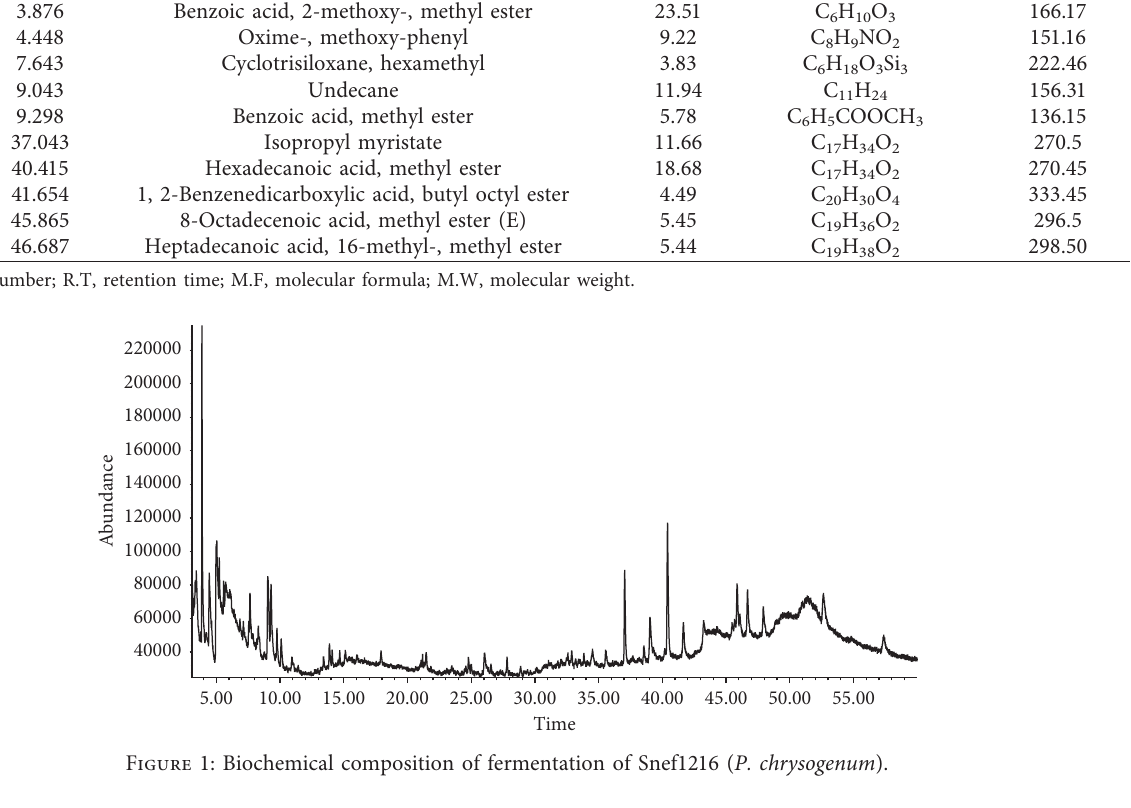
Table 3: Biochemical composition of fermentation of Snef1216 ( P. chrysogenum ). P. no.